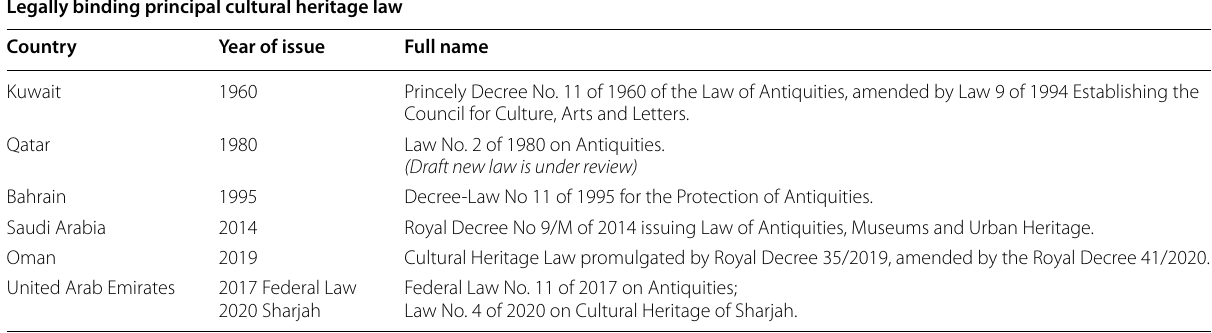
Table 2 The heritage protection laws in Gulf Cooperation